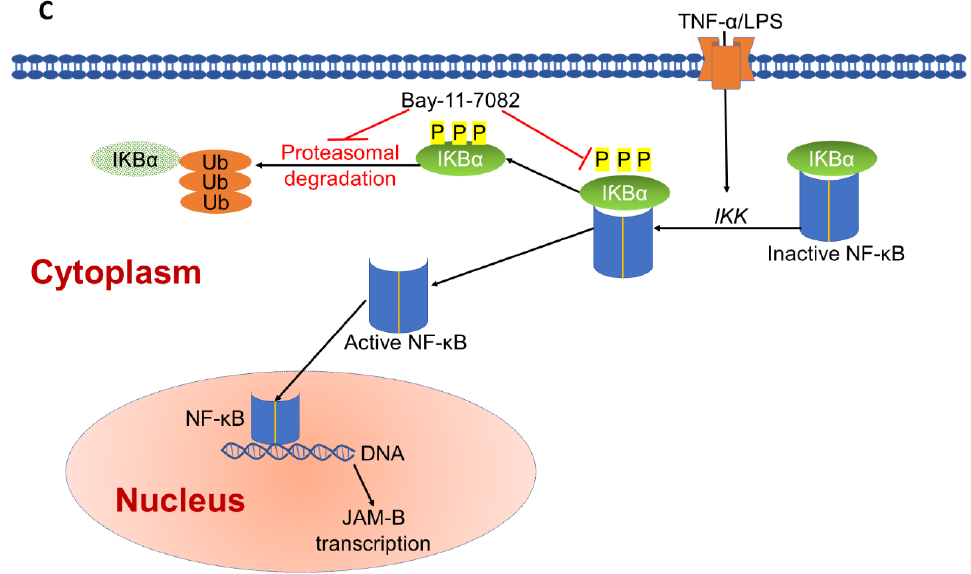
Figure 4. Regulation of JAM-B gene expression relative to the geometric mean of YWHAZ and ACT- β expression. ( A ) In THP1-1 monocytes, treatment with 10 µM of the NF-κB inhibitor Bay-11-7082 for 24 h did not further reduce JAM-B gene expression in the control samples but reduced JAM-B gene expression in the LPS (10 ng/mL) and TNF-α (10 ng/mL) treated samples ( p = 0.029, n = 4). ( B ) Addition of the p38α/β MAPK inhibitor (MT4) had no effect on JAM-B gene expression in control, LPS or TNF-α incubations. ( C ) Mechanisms through which the Bay-11-7082 inhibitor prevents TNF- α or LPS induced JAM-B gene expression mediated by NF- κβ . Bay-11-7082 inhibits the phosphorylation of IK β that is bound to inactive NF- κβ and the formation of poly-ubiquitination chains that aid the degradation of IK β , i.e., the effect of Bay-11-7082 is to prevent the phosphorylation and ubiquitin- dependent proteasomal degradation of IK β which remains bound to NF- κ B and effectively blocks the NF- κβ nuclear localisation sequence so that NF- κβ does not translocate to the nucleus and become active to induce JAM-B transcription. The observation that treatment with Bay-11-7082 completely abolishes the TNF α - and LPS-induced increases JAM-B gene expression strongly suggests that the TNF α - and LPS-induced increases in JAM-B expression are a consequence of increased phosphorylation and proteasomal degradation of IK β . * indicates p ≤